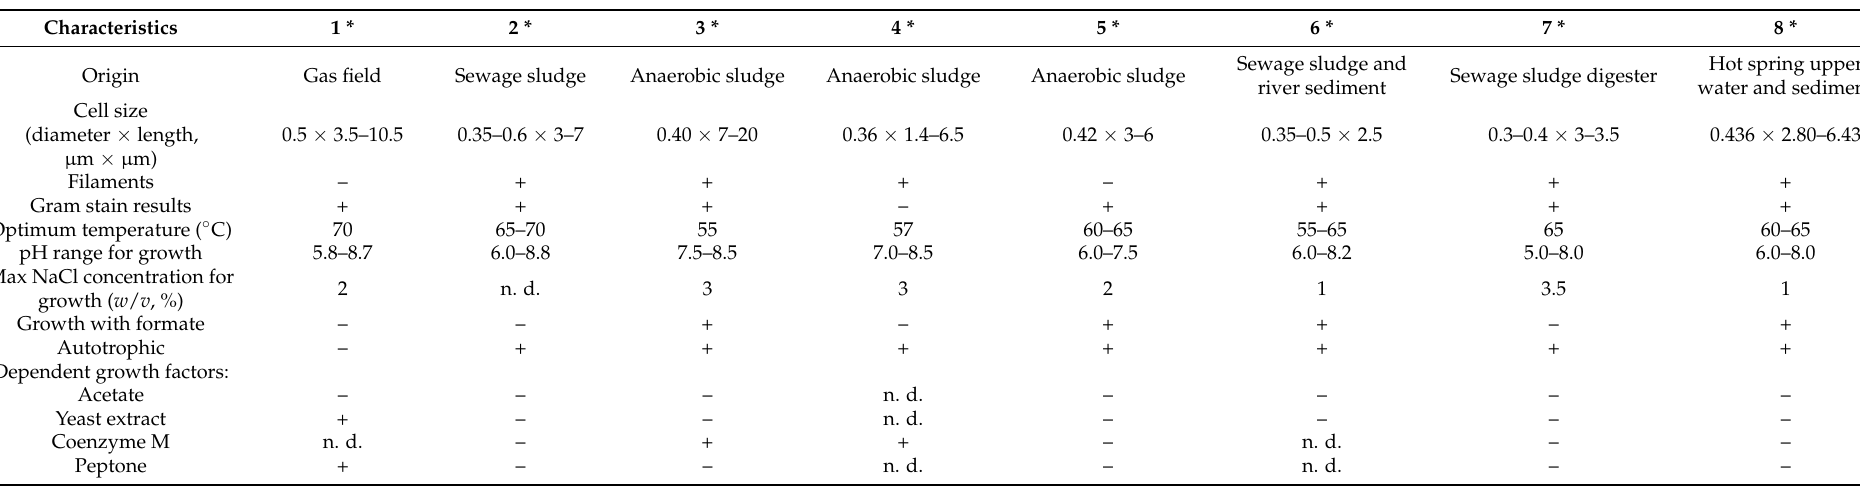
Table 1. Descriptive and catabolic features of M. tengchongensis DL9LZB001 compared with other members of the genus Methanothermobacter